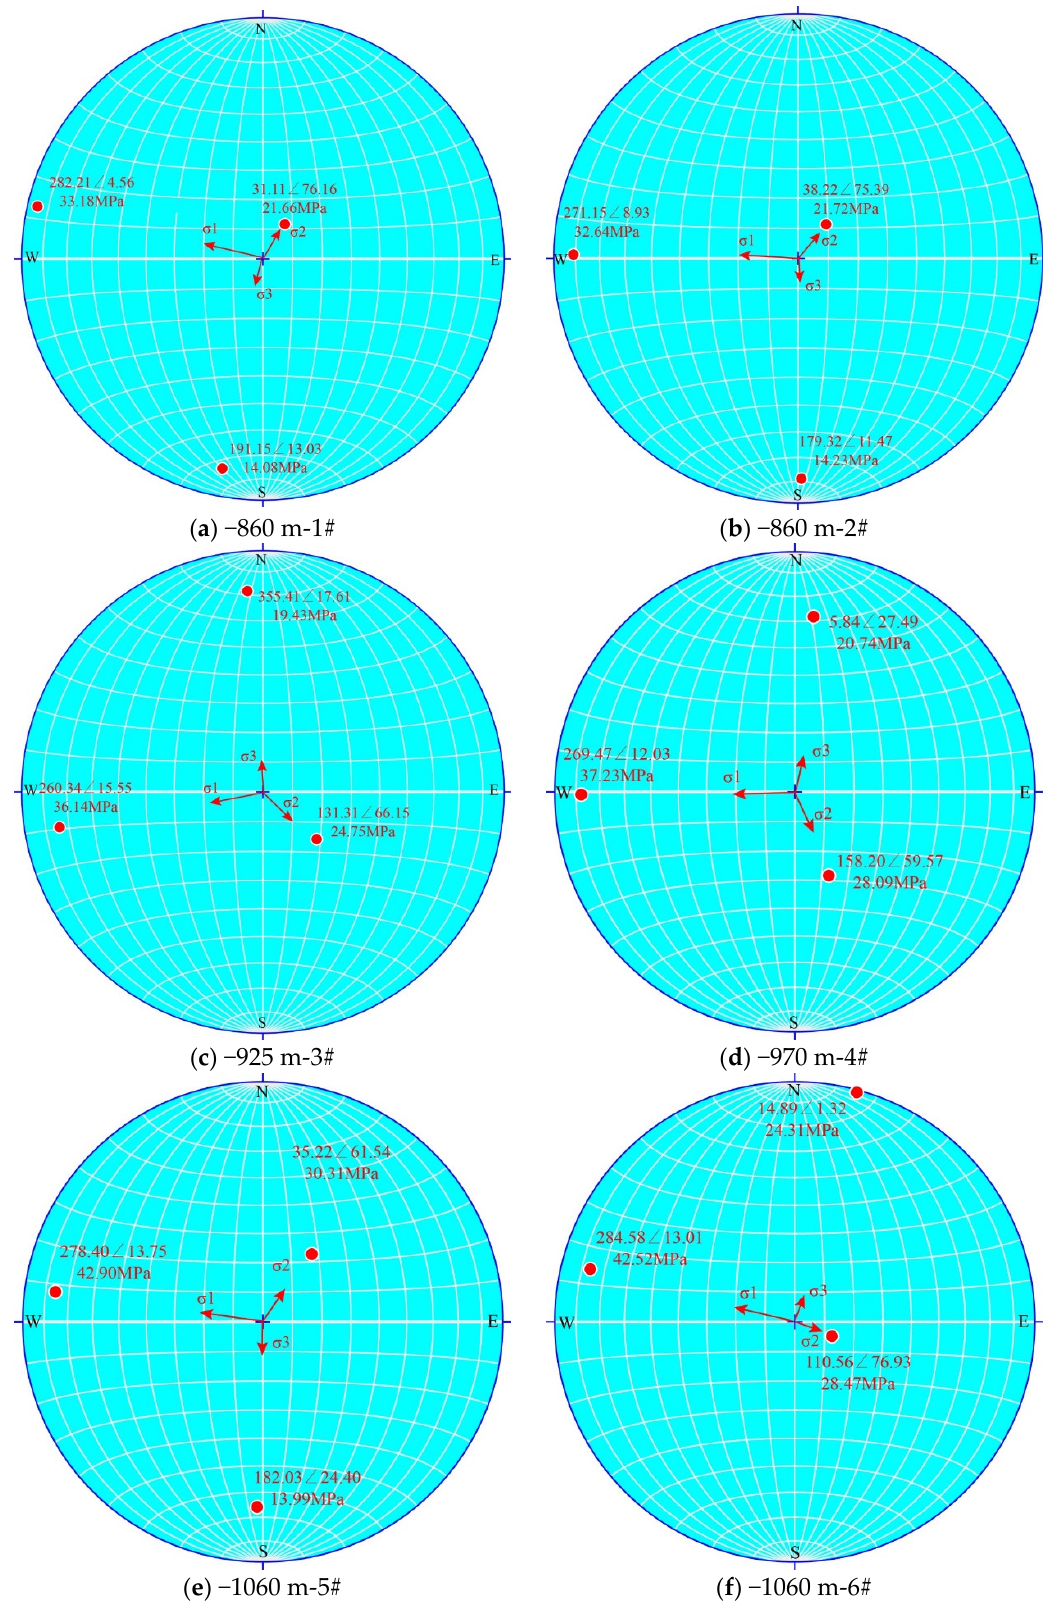
Figure 11. Stress relief method results: ( a ) 1# at depth of −860 m; ( b ) 2# at depth of −860 m; ( c ) 3# at depth of −925 m; ( d ) 4# at depth of −970 m; ( e ) 5# at depth of −1060 m; ( f ) 6# at depth of −1060 m.